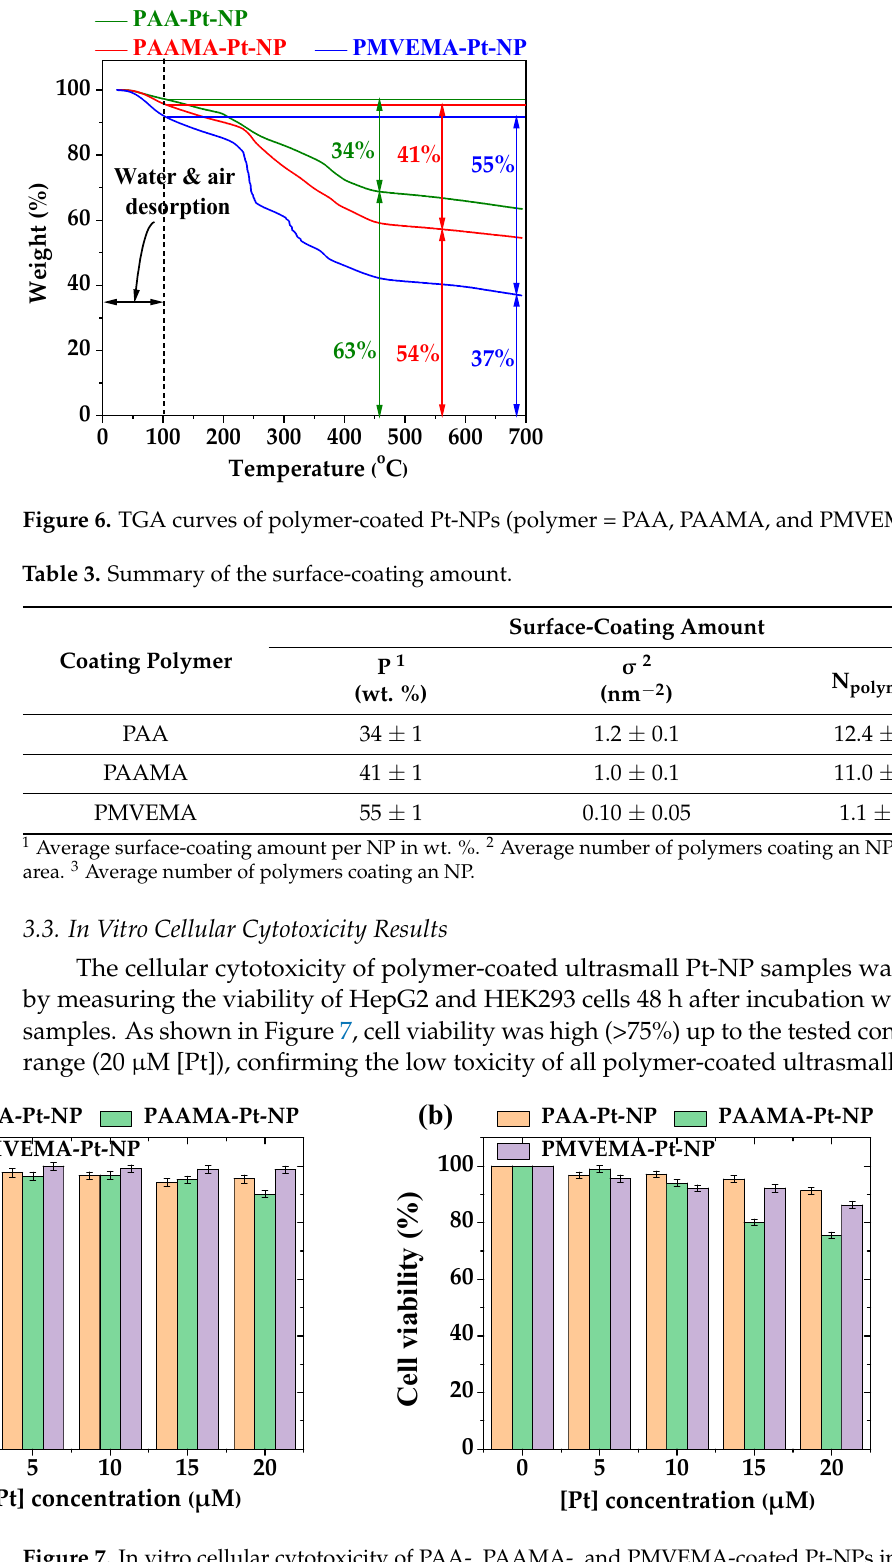
Figure 7. In vitro cellular cytotoxicity of PAA-, PAAMA-, and PMVEMA-coated Pt-NPs in ( a ) HepG2 and ( b ) HEK293 cells as a function of [Pt] concentration, showing low toxicity up to 20 µM [Pt].